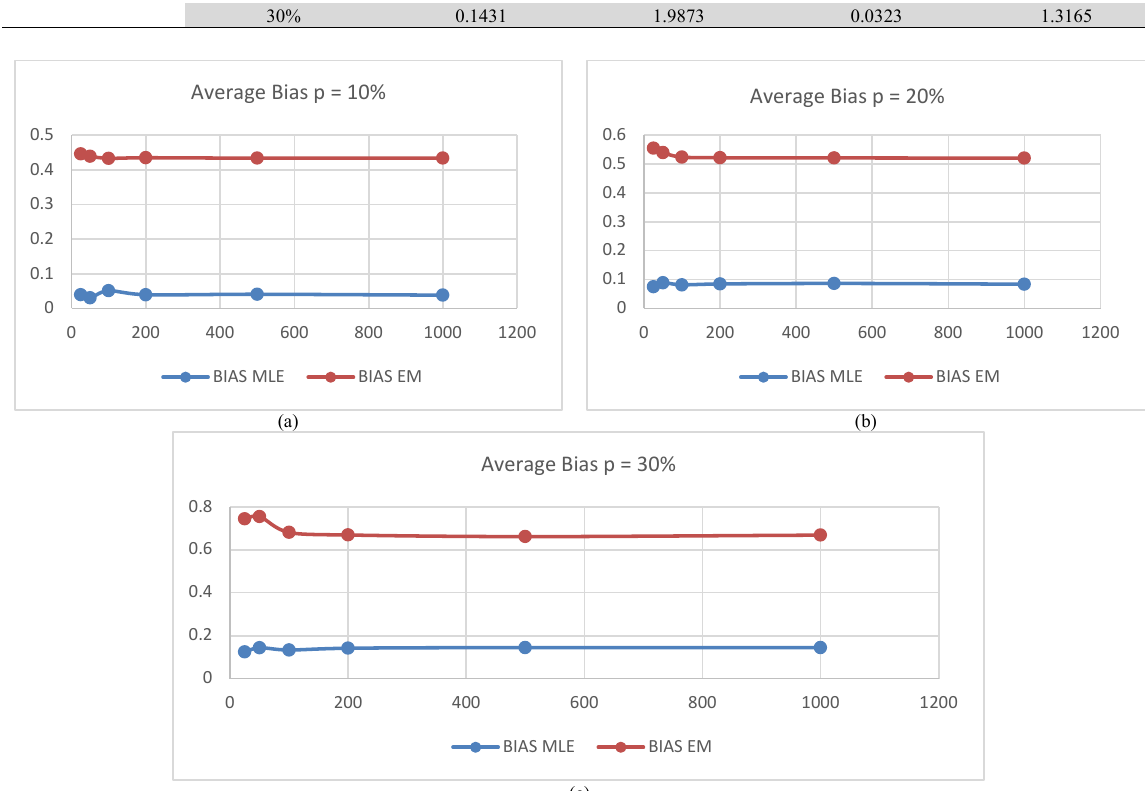
(c) Fig. 2 . Average Bias by method MLE and EM for the values of (a) p= 10%, (b) p=20%; and (c)